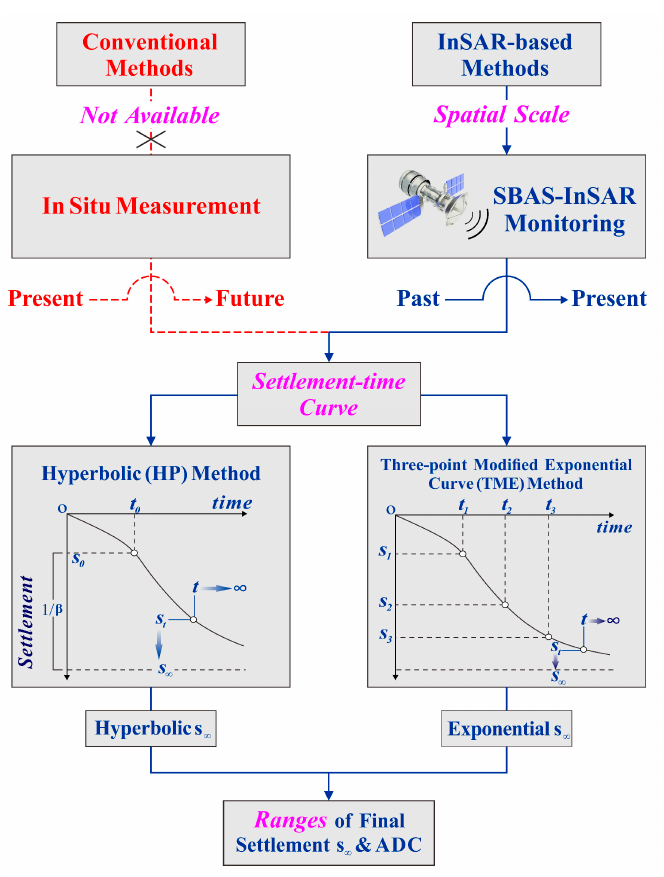
Figure 4. Diagram of the settlement curve acquisition and prediction method in this